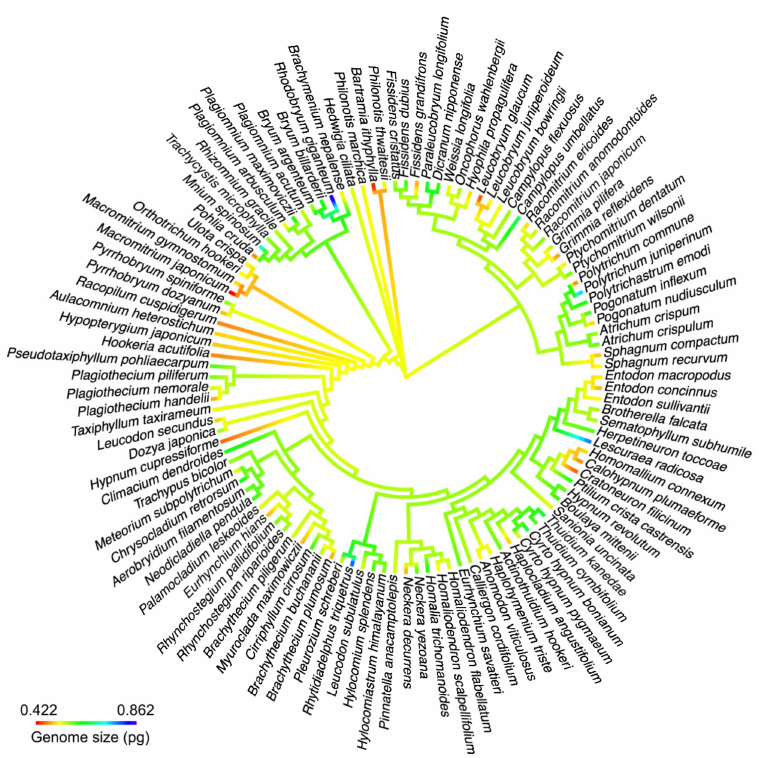
Figure 4. Continuous character state mapping of the average DNA 1C values (genome size), ranging from 0.422 pg (red) to 0.862 pg (blue), onto a ultrametric tree that includes 112 moss species, using the ContMap function with default settings from the phytools package in